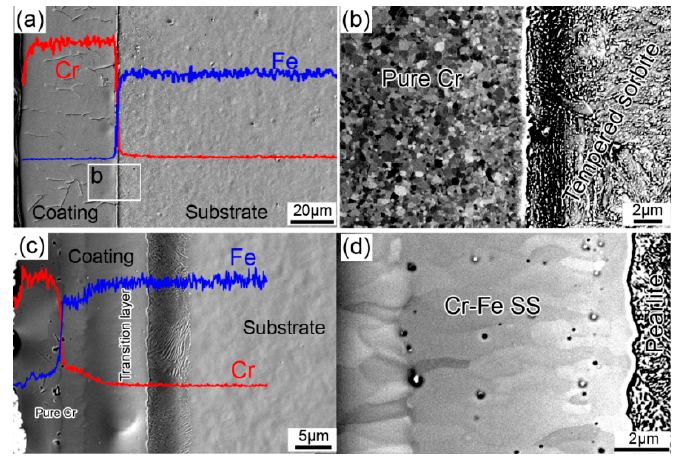
Figure 4. EDS line scans and BSEI images showing element distribution and microstructures of the coatings of A500 sample ( a , b ) and A1100 sample ( c , d ), respectively.